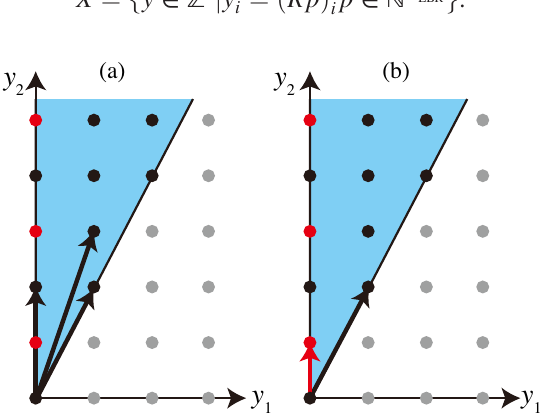
FIG. 3. (a) EFPs in SG 199 ( I 2 1 3 ). The shaded area represents the cone Y , the black points represent the trivial points in red points represent the EFPs, and the grey points correspond